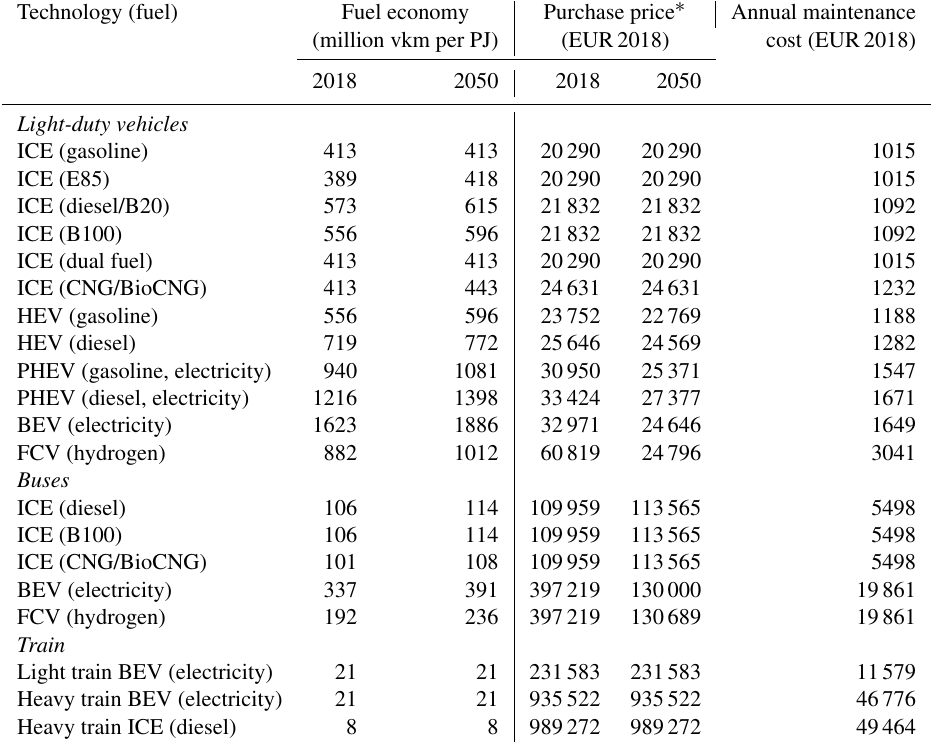
Table A7. Technoeconomic characteristics of passenger transport